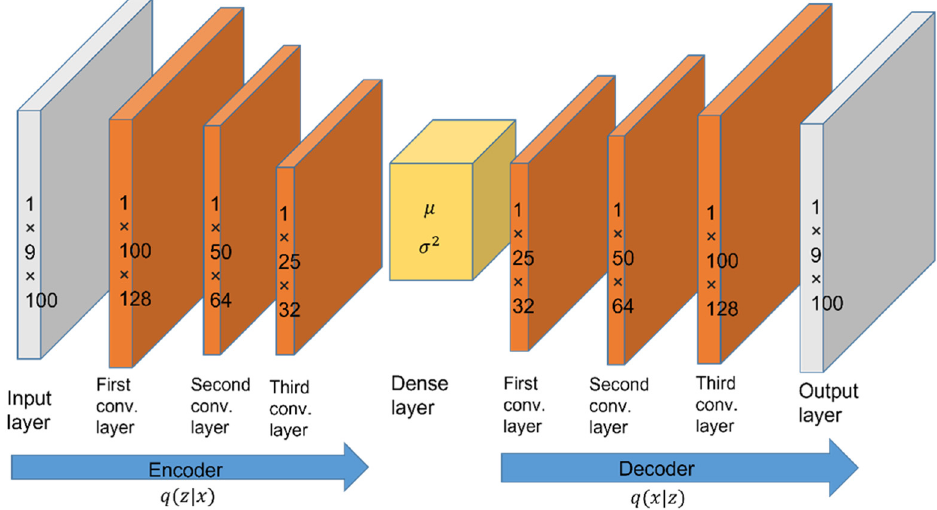
Figure 4. The proposed VAE architecture for data pre-training.